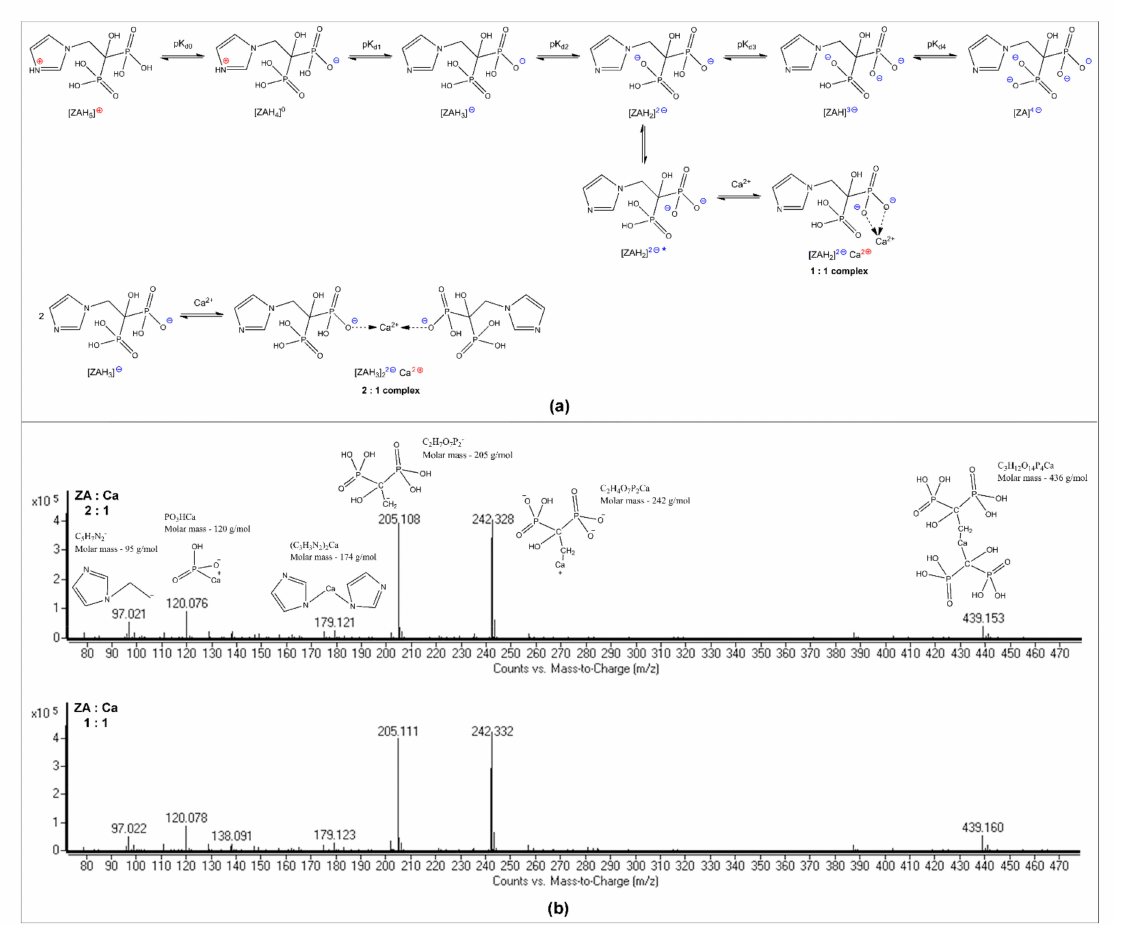
Figure 1. Complexes’ formation between Ca 2+ and ZA: ( a ) ZA dissociation and Ca 2+ complexation equilibria; ( b ) Confirmation of complexes’ formation by ESI-MS (ZA:Ca 2+ molar ratios of 2:1 and